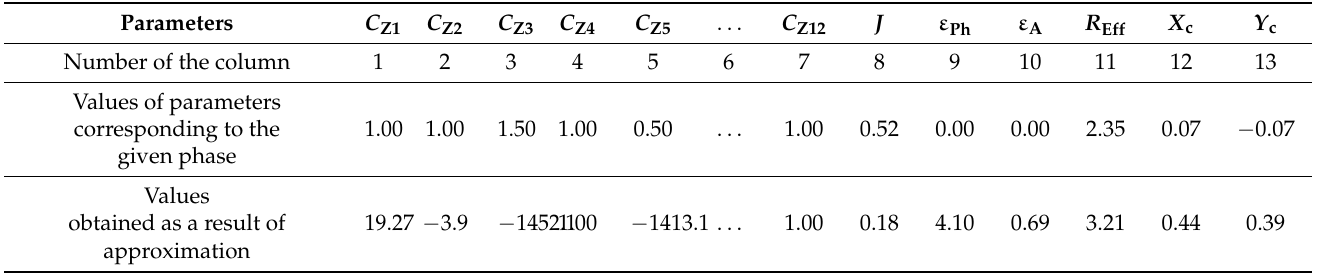
Table 3. The screen was set by 12 polynomials and approximated by 12 polynomials. Dimensions of computational grid are 256 × 256 nodes.